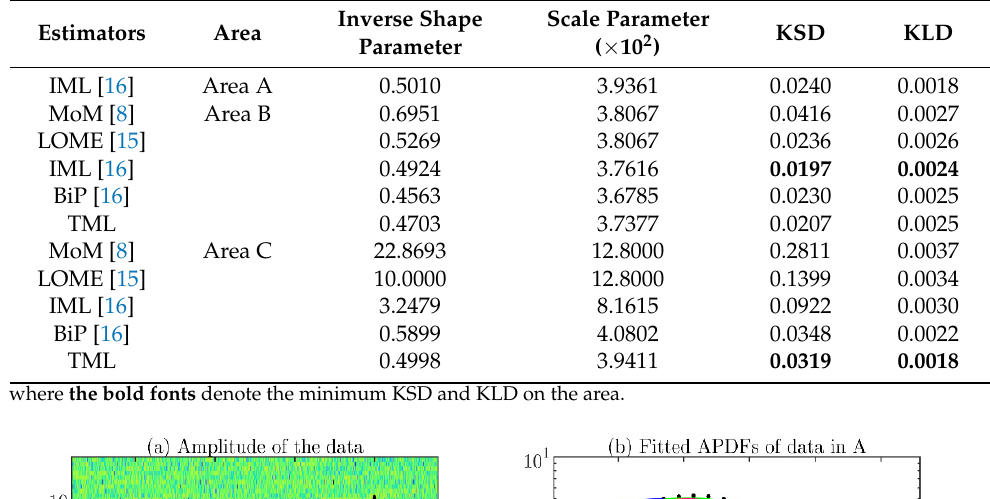
Table 1. Estimation results of the five estimators on a dataset from the IPIX radar database.